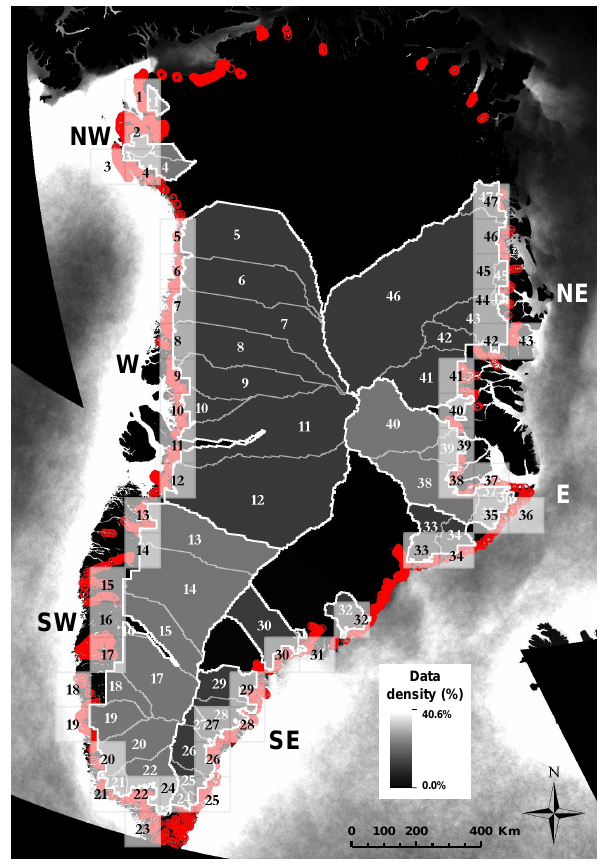
Fig. 3. Coastal 100km gridcells and their corresponding ice sheet drainage basins are overlaid onto an image showing data density (DD 500m ) for 10yr of MODIS 500m data, representing the number of open water days classified for each pixel out of a total of 1531 available and ranging from 0–40.6%. Regions of interest (ROIs, red circles) are manually drawn to restrict open water data to fjords draining the ice sheet. Gridcells are grouped into six regions for summary analysis: Northwest (NW), West (W), Southwest (SW), Southeast (SE), East (E), and Northeast (NE). The north/northeast and a swath along the southeast contain very low frequencies of detected open water days due to the presence of sea ice and glaciers heavily calving